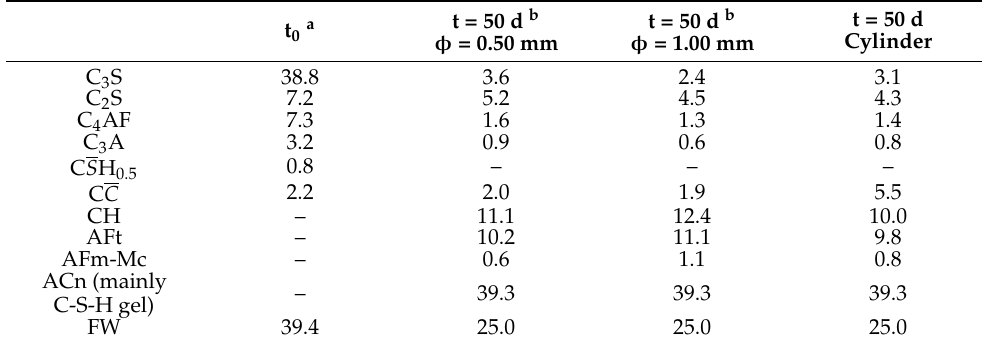
Figure 1. Thermal analysis data for the two neat pastes after 50 days of hydration with an isothermal heating at 40 °C for 30 min. The CH and C 𝐶̅ contents (wt%) are referenced to the pastes containing the free water. The total weight losses (%) are also shown. Table 2. RQPA results (wt%), including ACn and FW contents, for the w/c = 0.65 samples referred To 100 g of